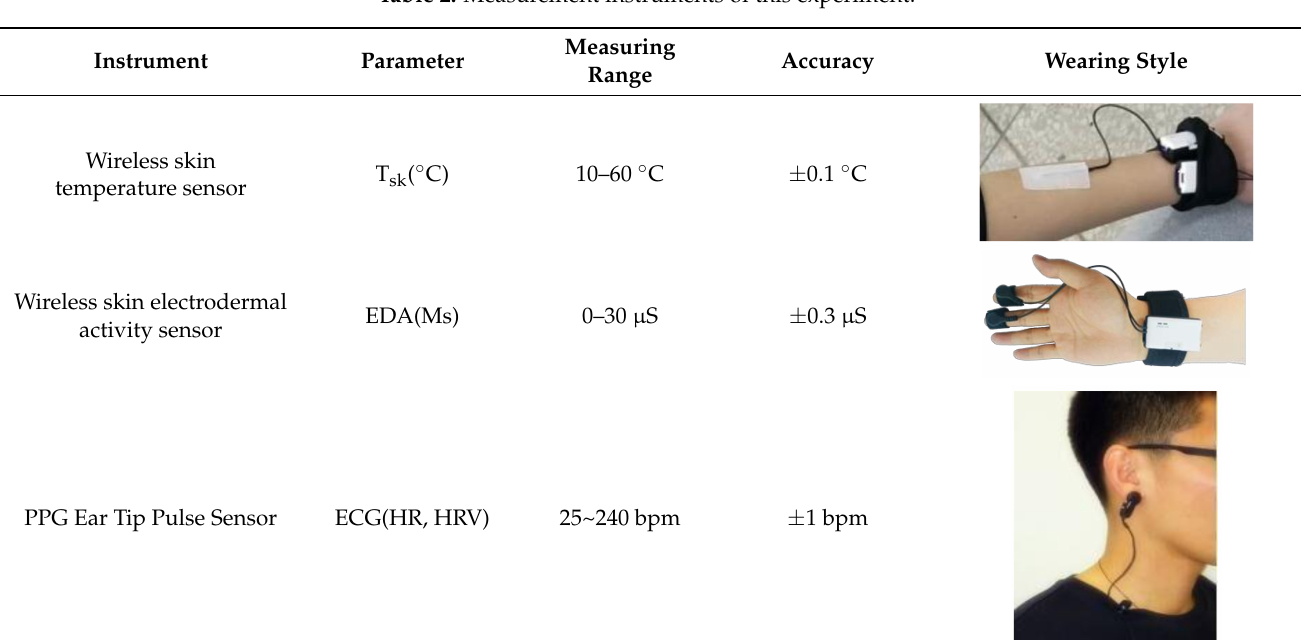
Table 2. Measurement instruments of this